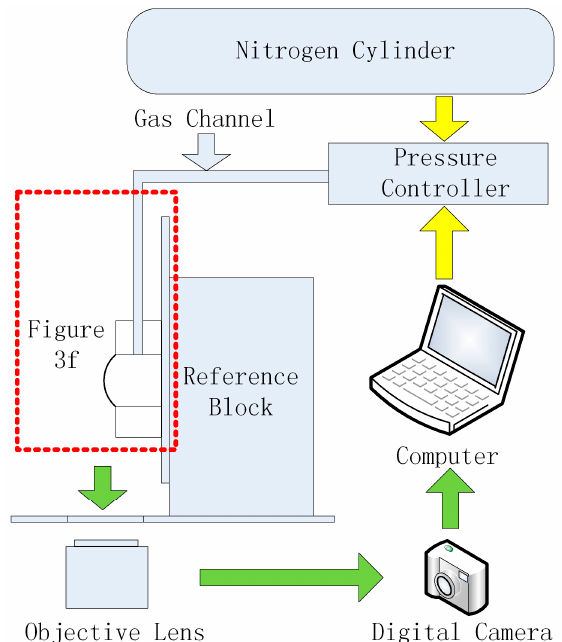
Figure 3. ( Left ) Flow charts of the fabrication process for the polydimethylsiloxane (PDMS) membrane testing chamber: ( a ) Fabricate the PDMS pie with parallel surfaces; ( b ) Punch a round hole in the PDMS pie; ( c ) Cut the PDMS pie into a small block with a round hole; ( d ) Punch a side hole in small PDMS block used as the uniform pressure channel; ( e ) Bond the PDMS block and microscope slide together by plasma treatment to ensure the seal; ( f ) Bond the PDMS membrane and PDMS block together, covering the round hole and obtaining a circular membrane, or acts as an unfinished micro-chip; ( Right ) Picture of the final experimental device.